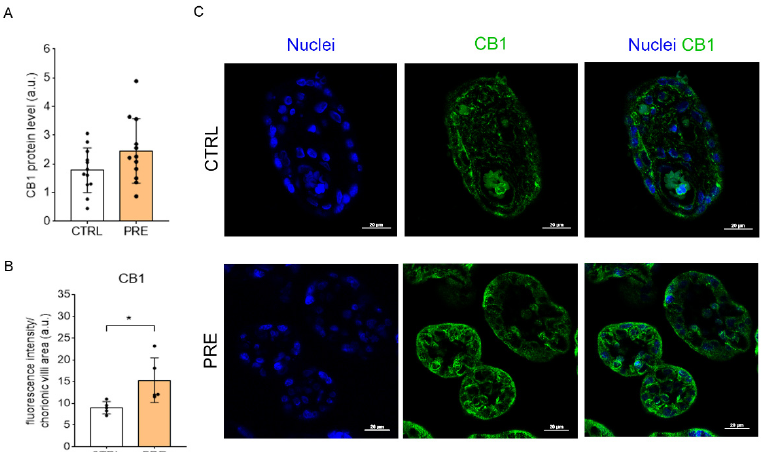
Figure 1. Relative levels of CB1 in the two experimental groups. ( A ): Analysis of the CB1 levels in placenta slices by western blot. Bars represent the densitometric analysis of CB1 (53 kDa)/ β -actin (42 kDa) ratio ± SD of twelve independent replicates ( n = 12). ( B ): Analysis of the CB1 levels in chorionic villi by immunohistochemistry. Bars represent the fluorescence intensity per area of chorionic villi ± SD of five independent samples ( n = 5). In confocal images ( C ), nuclei are marked with DAPI (blue) and CB1 is marked in green (Alexa Fluor ® 488); scale bar = 20 µm. Asterisk indicates significant differences (* = p < 0.05) when comparing preeclamptic samples to the control group.